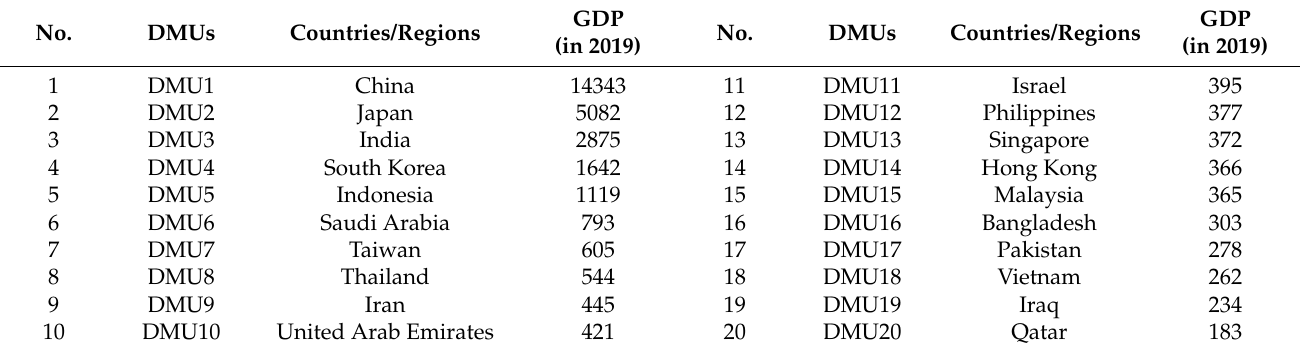
Table 1. Names of countries and decision-making units (DMUs) in respective (gross domestic product (GDP) in billion US dollars). Source: World